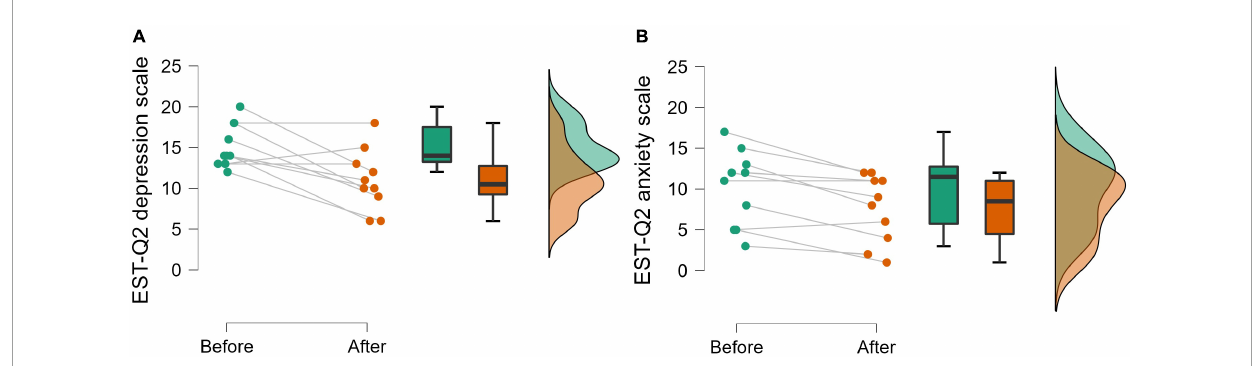
FIGURE3 A raincloud plot of the EST-Q2 depression scale (A) and anxiety scale (B) scores as measured before the experiment and 2 weeks after. Depicted are individual scores, as well as boxplots and density distributions of the results ( N = 10).